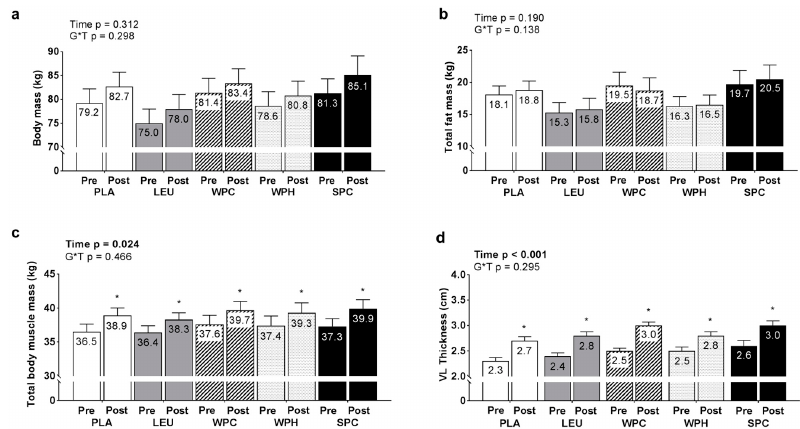
Figure 4. Changes in body composition variables and vastus lateralis muscle thickness between groups. Legend: Data include pre- and post-intervention body mass values ( panel a ), total fat mass values determined by dual x-ray absorptiometry (DXA; panel b ), total body muscle mass (TBMM) values determined by DXA ( panel c ), and vastus lateralis (VL) thickness determined by ultrasonography ( panel d ). Each bar graph depicts group averaged data presented as mean + standard error values, and mean values are presented within each bar. Additional abbreviations: PLA, maltodextrin placebo; LEU, L-leucine; WPC, whey protein concentrate; WPH, whey protein hydrolysate; SPC, soy protein concentrate; Symbol: * within-group increase from pre- to post training ( p < 0.05).